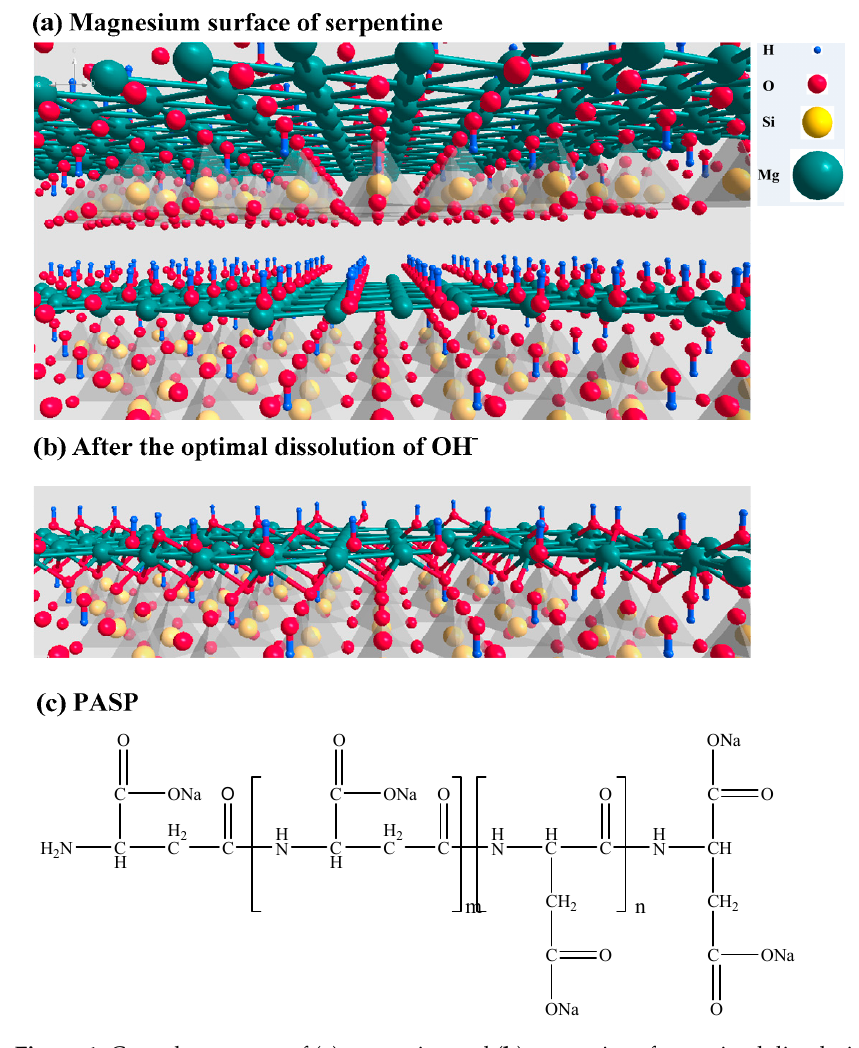
Figure 1. Crystal structures of ( a ) serpentine and ( b ) serpentine after optimal dissolution of hydroxyl ion, and ( c ) the molecular structure of PASP.